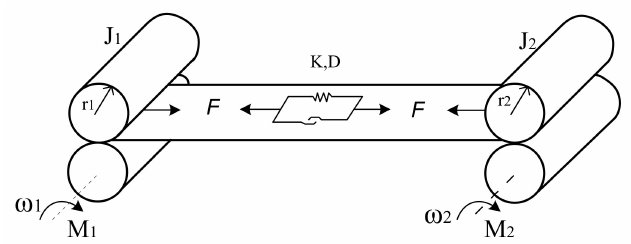
Figure 1. Two-mass system with elasticity.